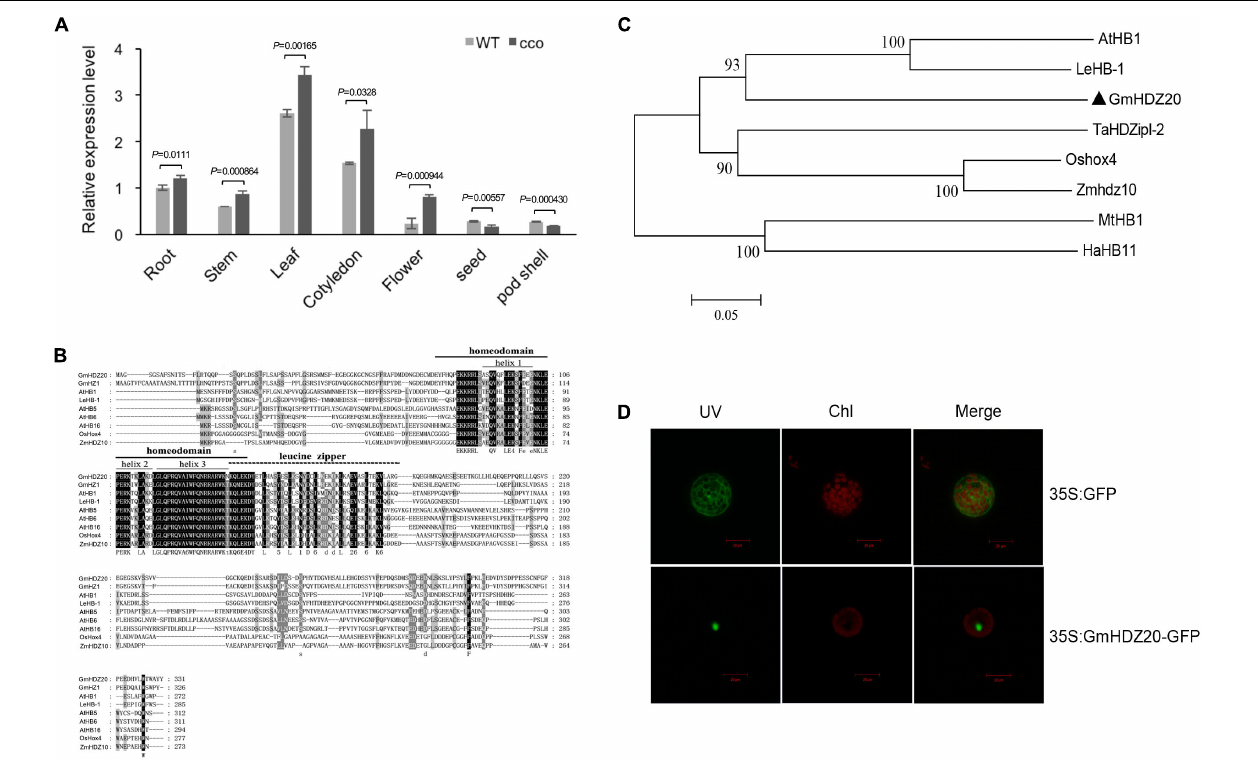
FIGURE 8 | Sequence analysis, tissue-specific expression, and subcellular localization of GmHDZ20 . (A) Tissue expression patterns of GmHDZ20 in various organs in the WT and the cco mutant. GmHDZ20 expression in root tissue was used as a control (expression value = 1). Means and SDs of three biological replications are shown. Statistical analysis was performed using paired-samples t -test (two-tail). (B) Sequence alignment of GmHDZ20 with other HD-Zip I homologs from different plant species. Black and gray indicate amino acid residues with different degrees of conservation. (C) Phylogenetic tree of GmHDZ20 and other plant HD-Zip I genes. GmHDZ20 homologous genes used are listed as follows: GmHZ1 (AY823671) from soybean ( Glycine max ); AtHB1 (AT3G01470), AtHB5 (AT5G65310), AtHB6 (AT2G22430), and AtHB16 (AT4G40060) from Arabidopsis thaliana ; LeHB-1 (TC183162/Solyc02g086930) from tomato ( Lycopersicon esculentum ); Oshox4 (AF145728) from rice ( Oryza sativa ); Zmhdz10 (GRMZM2G041127) from maize ( Zea mays L .); TaHDZipI-2 (DQ353856) from wheat ( Triticum aestivum L .); MtHB1 (XM_003627463/Medtr8g026960) from Medicago truncatula ; and HaHB11 (DY923855) from sunflower ( Helianthus annuus ). (D) Subcellular localization of the GmHDZ20-GFP fusion protein. UV, Chl, and Merge represent GFP fluorescence, chlorophyll fluorescence, and a combination of the green and red images, respectively. A non-fused 35S:GFP construct served as a control. Scale bars: 20 µ m. This experiment was performed three times with similar